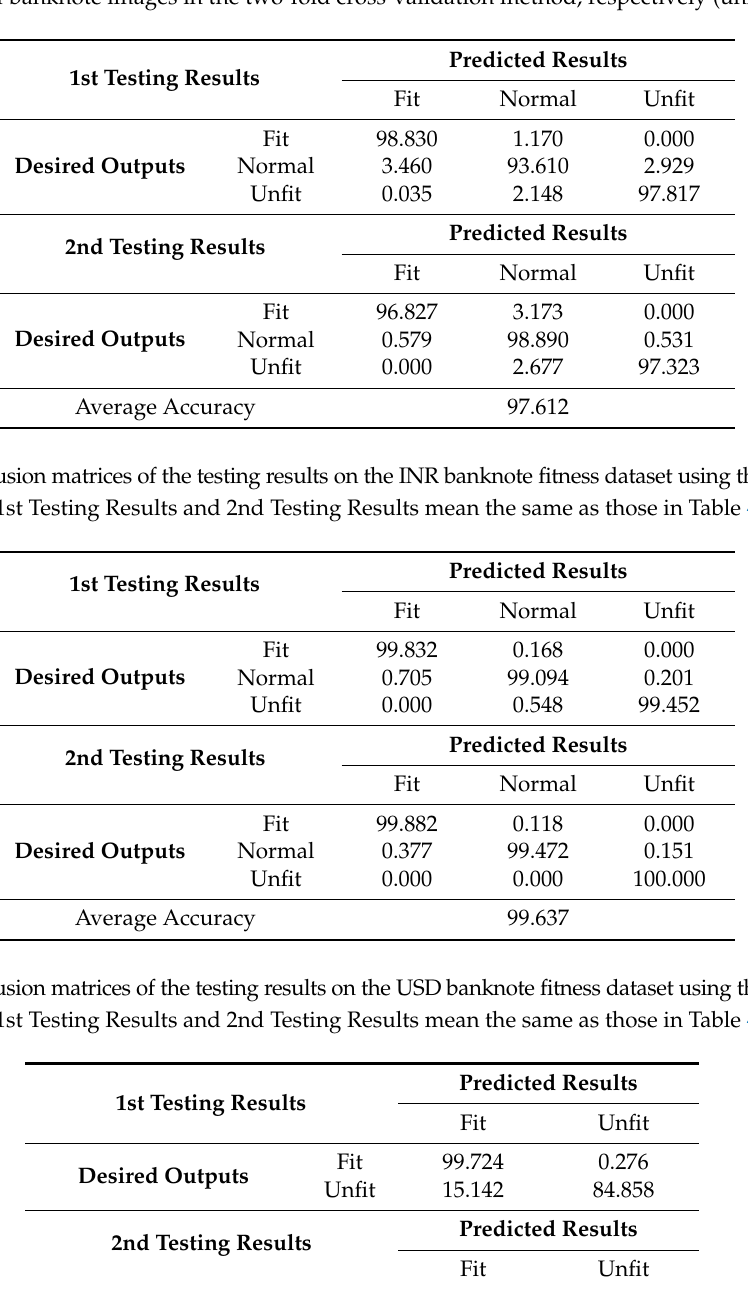
Table 4. Confusion matrices of testing results on the KRW banknote fitness dataset using the proposed method. The 1st Testing Results and 2nd Testing Results mean the results of the testing on the 1st and